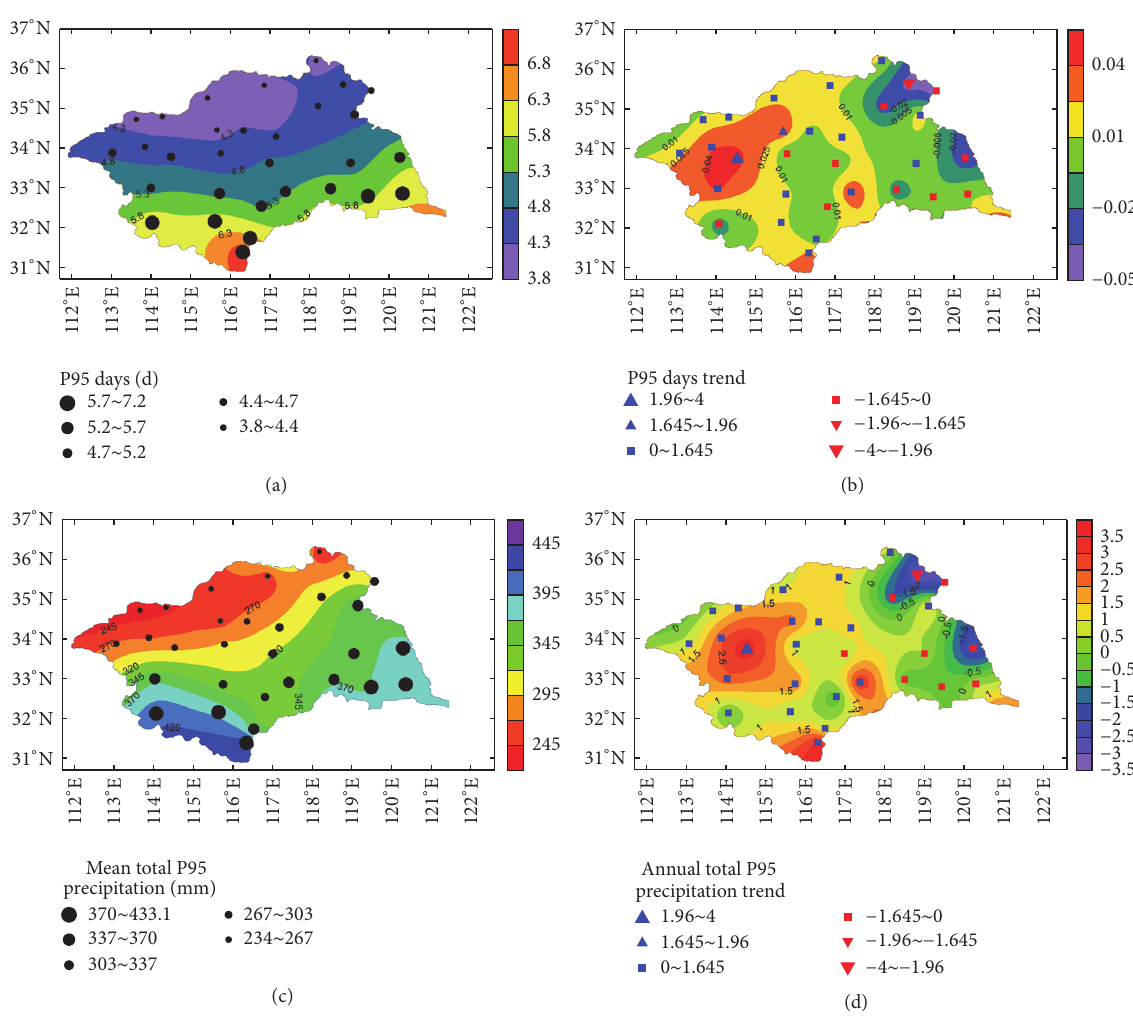
Figure 8: Spatial distribution of extreme precipitation days (a) and its slope and trend (b); extreme precipitation total (c) and its slope and trend (d).